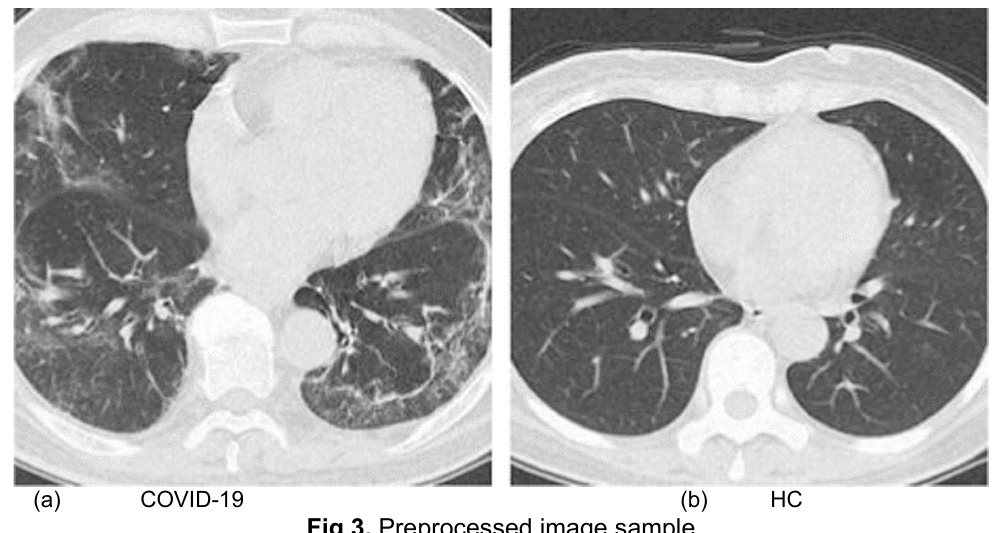
Fig 3. Preprocessed image sample